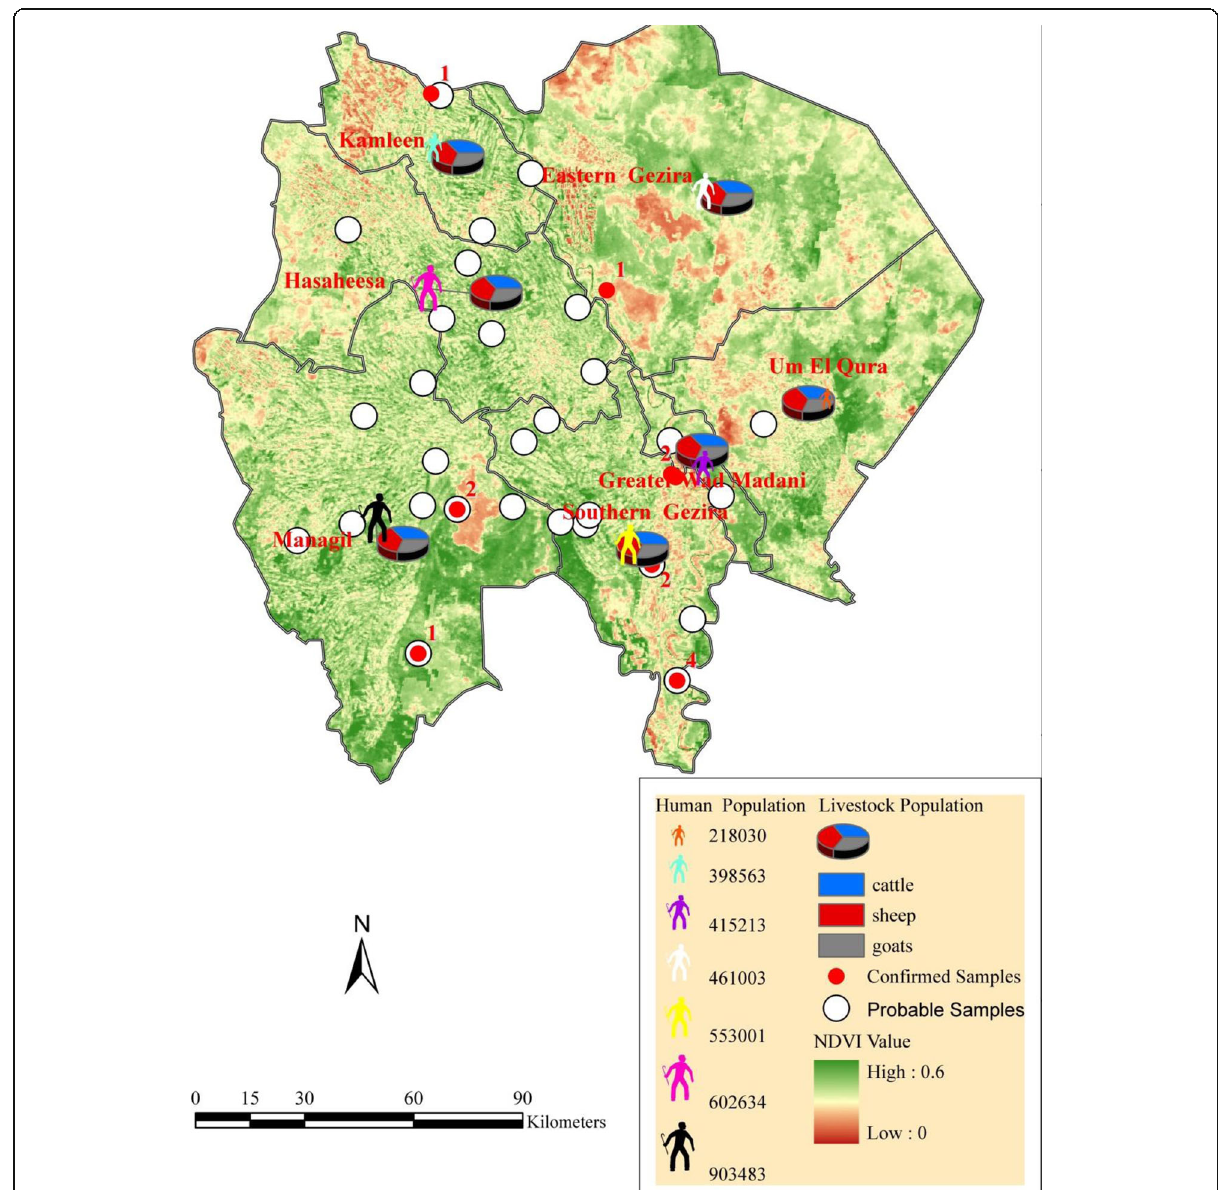
Fig. 5 NDVI for Gezira state overlaid with RVF human cases (confirmed, probable) and the animal population as a pie chart (percentage) and human populations as a simple gradient